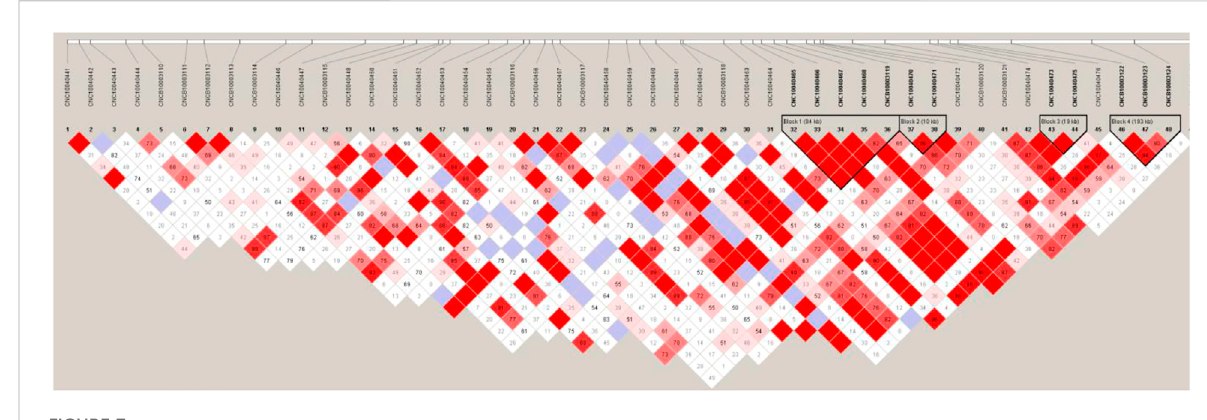
FIGURE 7 Haploview of linkage disequilibrium of SNPs on chromosome four (20.03 – 21.83 Mb) in Yunan